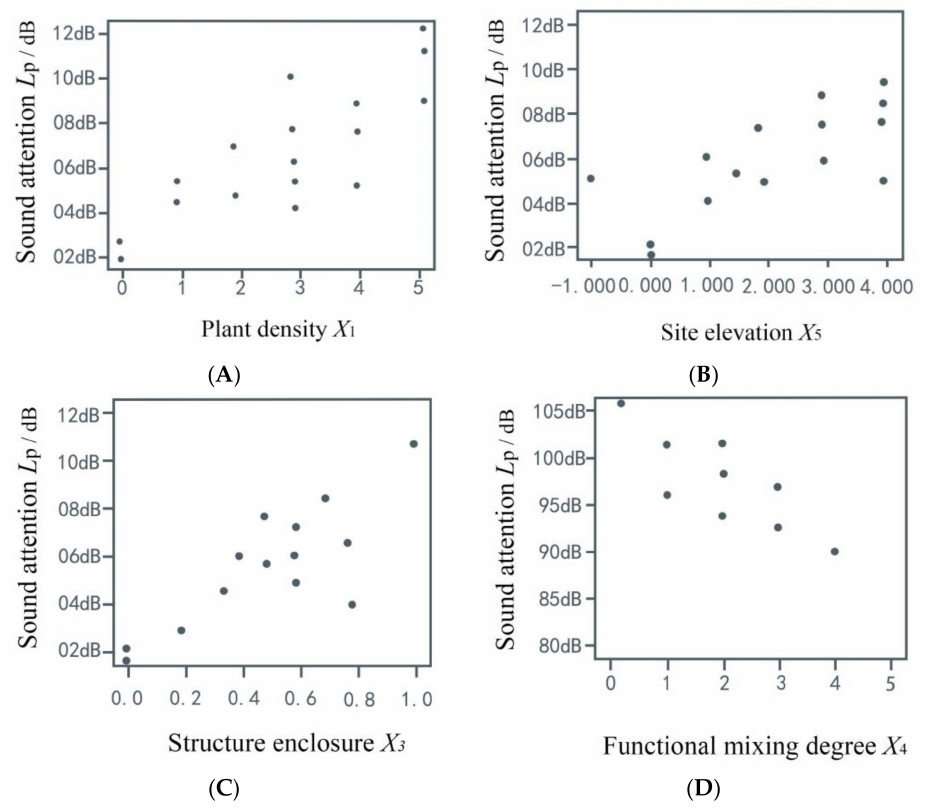
Figure 6. Sound intensity model diagram. ( A ) Plant density has a positive correlation with sound attenuation. ( B ) Site elevation has a positive correlation with sound attenuation. ( C ) Degree of structural enclosure has a positive correlation with sound attenuation. ( D ) Functional mixing degree has a negative correlation with sound attenuation.